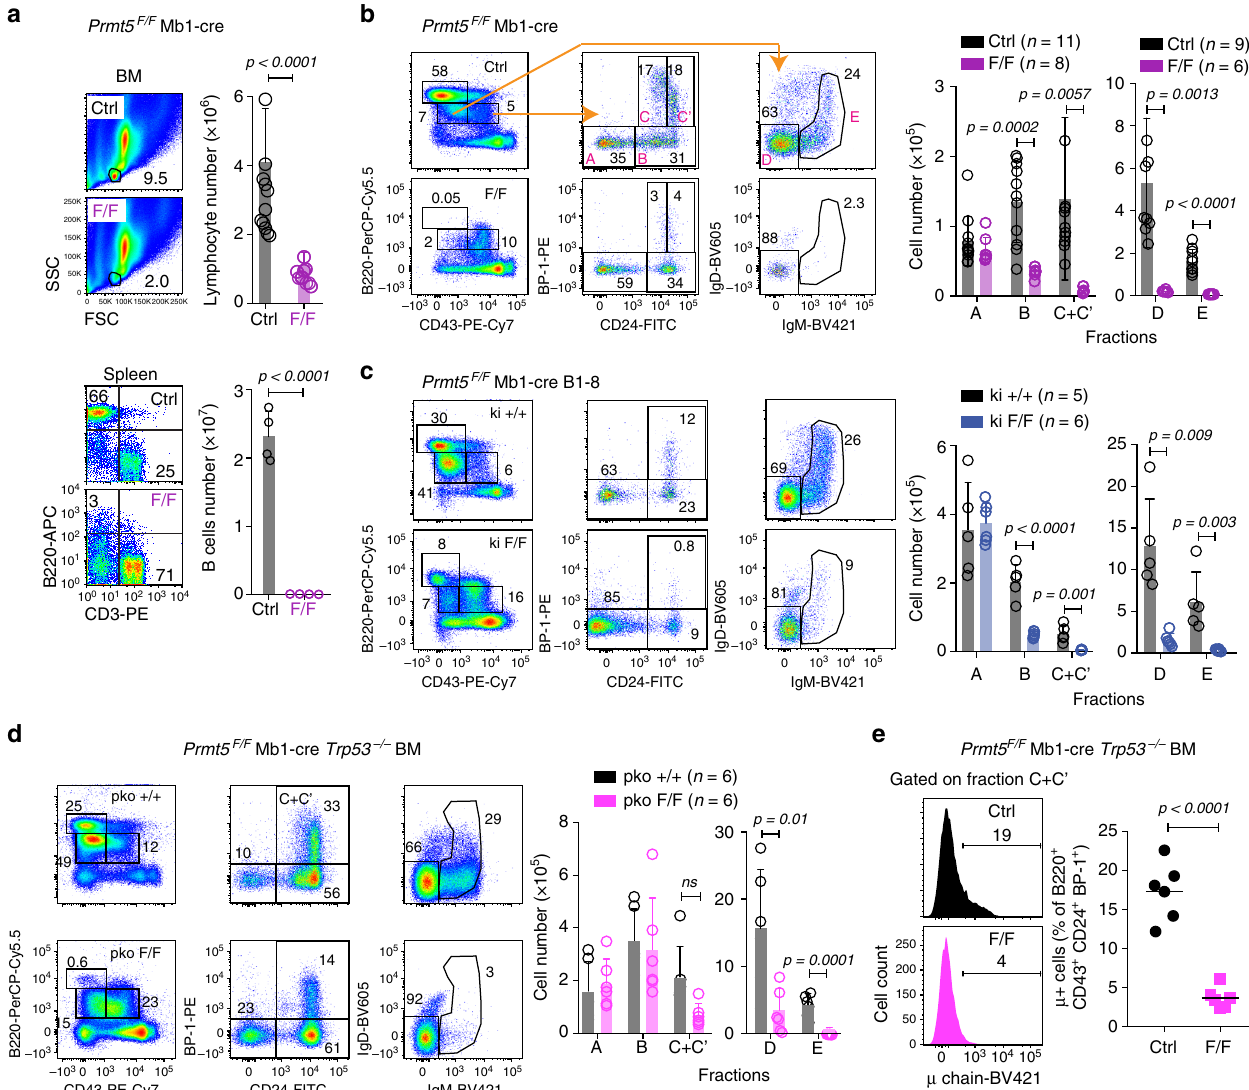
Fig. 7 Prmt5 is required for B cell development. a BM lymphocytes and splenic B cells in MB1-cre (Ctrl) or Prmt5 F/F MB1-cre (F/F) mice. Representative fl ow cytometry plots and bar plots of mean + s.d. absolute lymphocyte counts for n mice from four experiments. b Representative fl ow cytometry plots gating for Hardy fractions A to E in BM from 3 – 4-months-old MB1-cre (Ctrl) and Prmt5 F/F MB1-cre (F/F) mice. Means + s.d. of absolute cell numbers for each fraction from n of mice from four independent experiments are plotted. c As in b , for MB1-cre B1-8 (ki + / + ) and Prmt5 F/F MB1-cre B1-8 (ki F/F) mice, from three experiments. d As in b , for MB1-cre Trp53 − / − (pko + / + ) and Prmt5 F/F MB1-cre Trp53 − / − (pko F/F) mice, from three experiments. e Proportion of large Pre-B cells in fractions C + C ′ estimated by the pre-BCR expression in individual (symbols) MB1-cre Trp53 − / − (Ctrl) and Prmt5 F/F MB1-cre Trp53 − / − (F/F) mice. p -Values throughout are from an unpaired, two-tailed Student's t